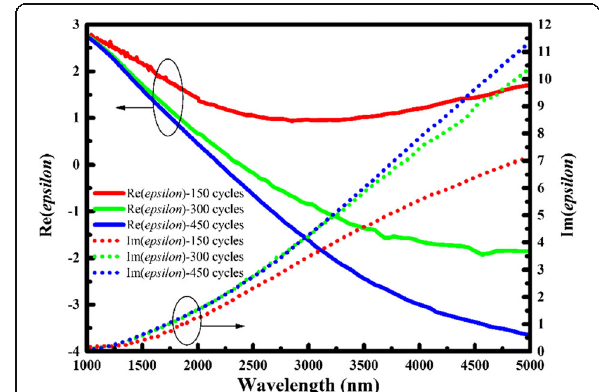
Fig. 4 The real part and imaginary part of epsilon of AZO films with different thicknesses, which was calculated from n and k ( e ε r ¼ n 2 − k 2 þ i (cid:2) 2 nk )